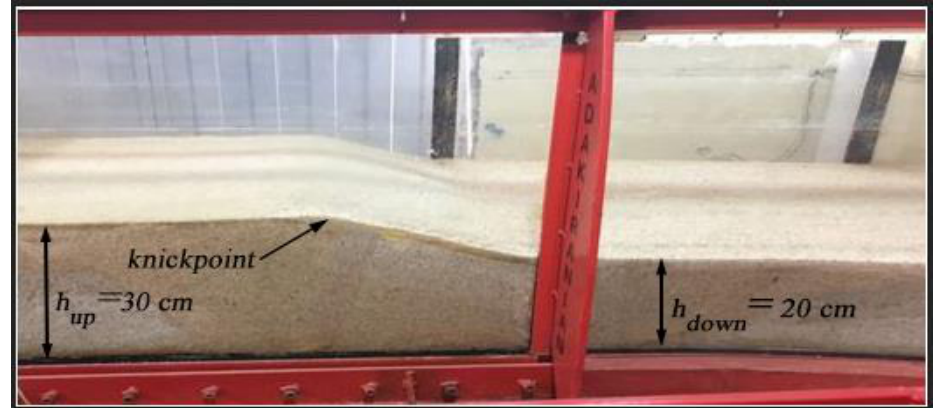
Figure 3. Base-level fall from the beginning of the bend to the end of the downstream straight